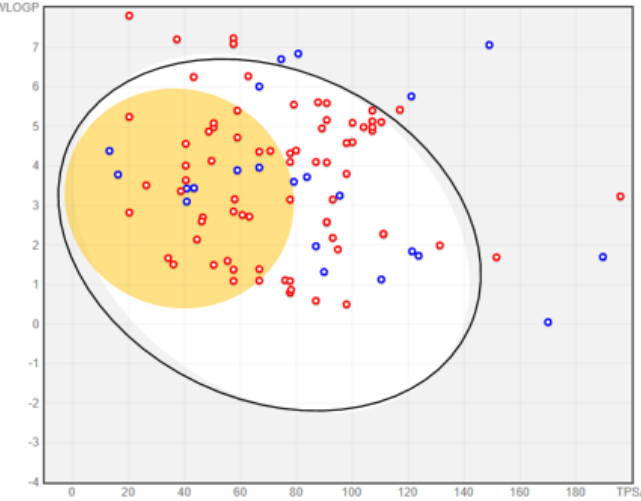
Figure 9. BOILED-Egg predictive model for absorption and bioavailability of AMNPs. The markers (dots representing AMNPs) within the white region are occupied by molecules (77% of AMNPs) that are most likely to be passively absorbed by the gastrointestinal tract (HIA). Those markers within the yellow region show AMNPs (34%) that are most likely to pass through the BBB. The markers that are outside the white region and few others that are out of the range (WlogP > 8 and TPSA > 200) are compounds that might be poorly absorbed. The blue and red markers represent substrates and non-substrates of p-gp, respectively.